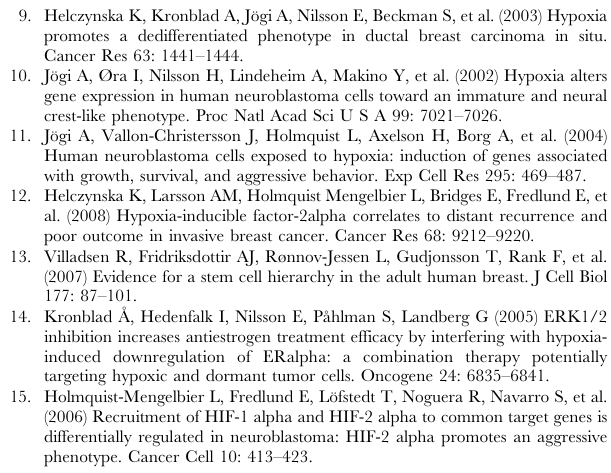
(TIF) Figure S2 Ki-67 (green) expression in MCF-10A cells growing in monolayer within the 3D-cultures 21 days post-seeding. Visualization of actin was by phalloidin (red). Size bar 40 m m. (TIF) Figure S3 Epithelial-to-mesenchymal-transition could not be detected in the hypoxic MCF-10A cells in 3D- cultures. A. Immunofluorescence staining of E-cadherin after 21 days of 3D-culture on ECM-derived substrate at normoxic (21%) and hypoxic (1%) conditions. The confocal micrographs were acquired at the Z-plane where the depictured acini-like structure had the widest circumference. Size bars 20 m m. B. Relative mRNA expression levels of E-cadherin and Vimentin in normoxic and hypoxic 3D-cultures after 21 days showing data from three independent experiments. Statistical analysis was performed with Student’s paired t-test (p). C . E-cadherin protein levels in MCF- 10A cells recovered from normoxic (21%) and hypoxic (1%) 3D- cultures after 3, 12, and 21 days, analyzed by immunoblot. (TIF) Table S1 Sequences of the QPCR primers.